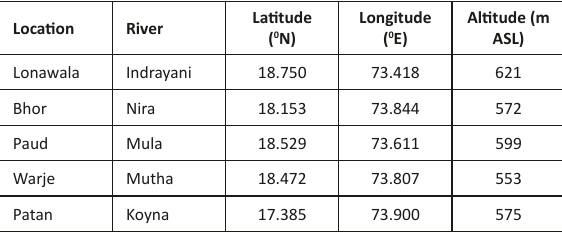
Table 1. Investigated